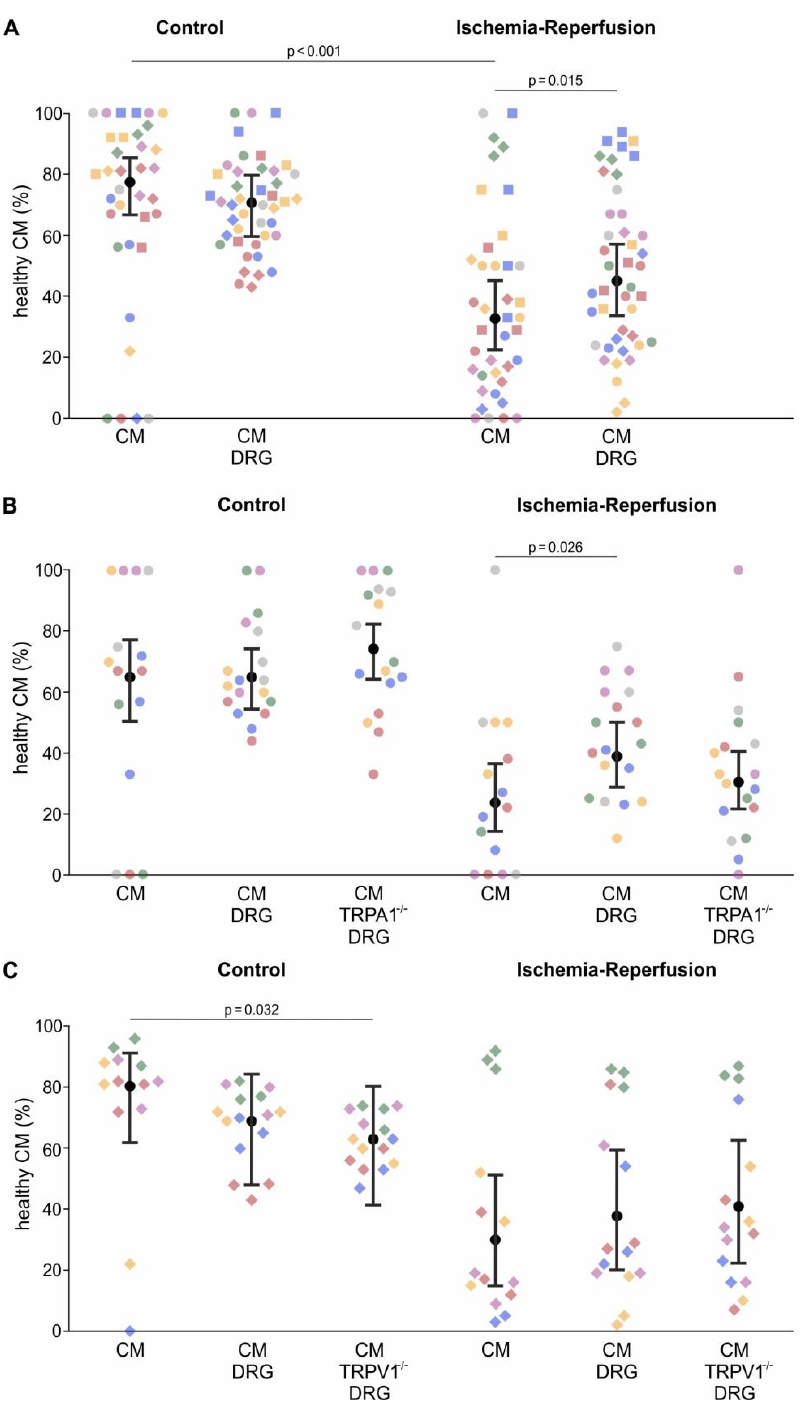
showing cardiomyocytes that disappear from the spot and the lower insets showing two cardiomy- ocytes that round-up as sign of irreversible damage. Images were acquired with identical settings and are visualised with identical brightness and contrast. Magnified insets have an edge length of 93 µm.